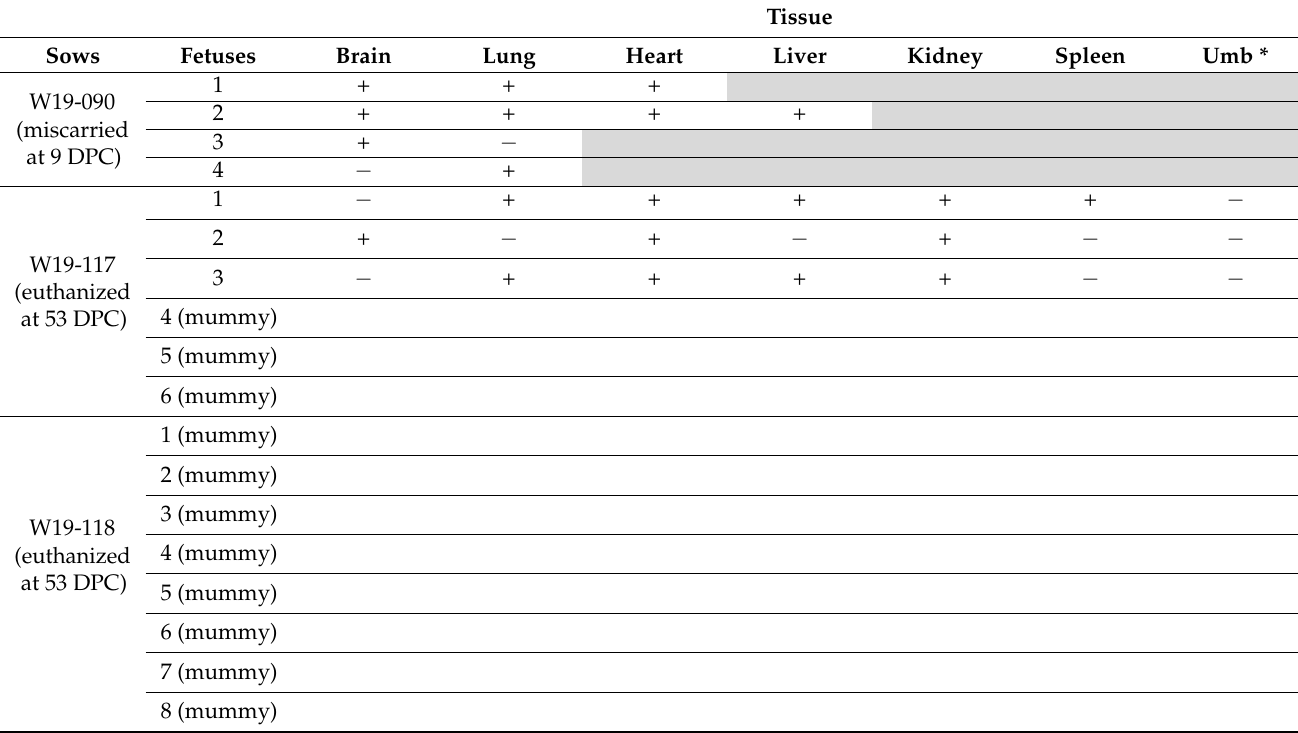
Table 2. PPV1 detection in fetal tissues from sows infected with the PPV1-190313 strain on